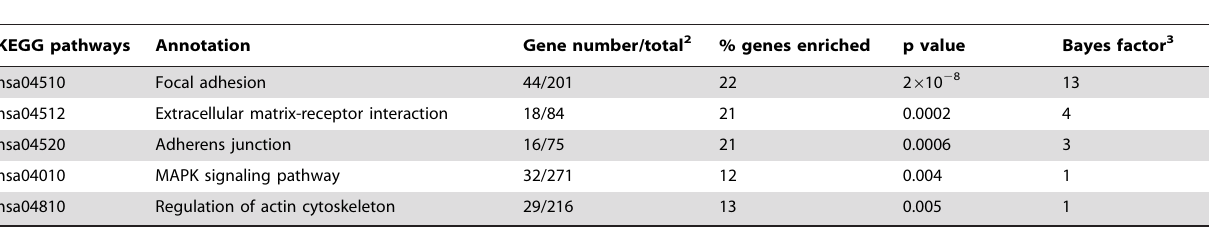
Table 2. GATHER KEGG Pathway Analysis of the Human Airway Basal Cell-enriched Transcriptome. 1